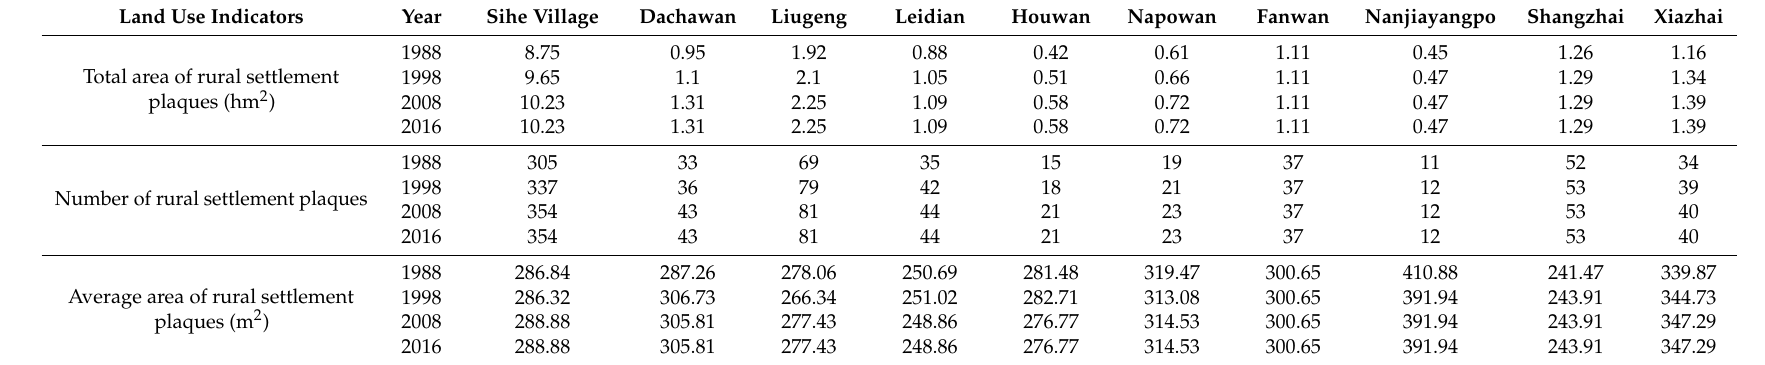
Table 9. Indicators of land use scale in Sihe village and its communities from 1988 to